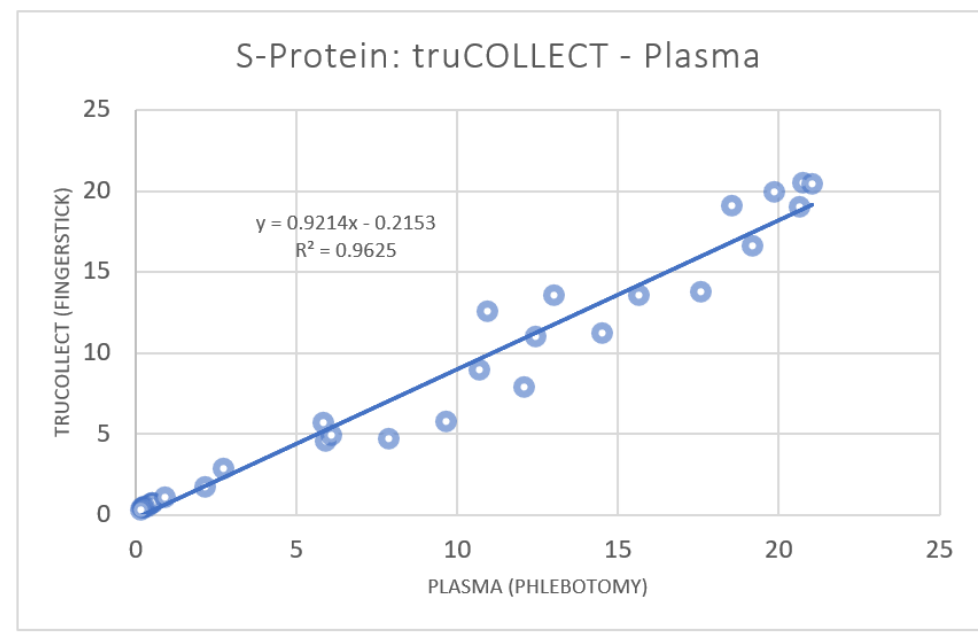
Figure 4. Correlation of SARS-CoV-2 S-protein antibodies in paired plasma and truCOLLECT samples. A comparison of absorbance measurements from 31 donors using the SARS-CoV-2 Spike Glycoprotein ELISA kit (Abcam). Capillary fingerstick blood collected with truCOLLECT (Y-axis), and Venipuncture derived plasma (X-axis) are examined; r 0.981; 95% CI [0.96, 0.99].